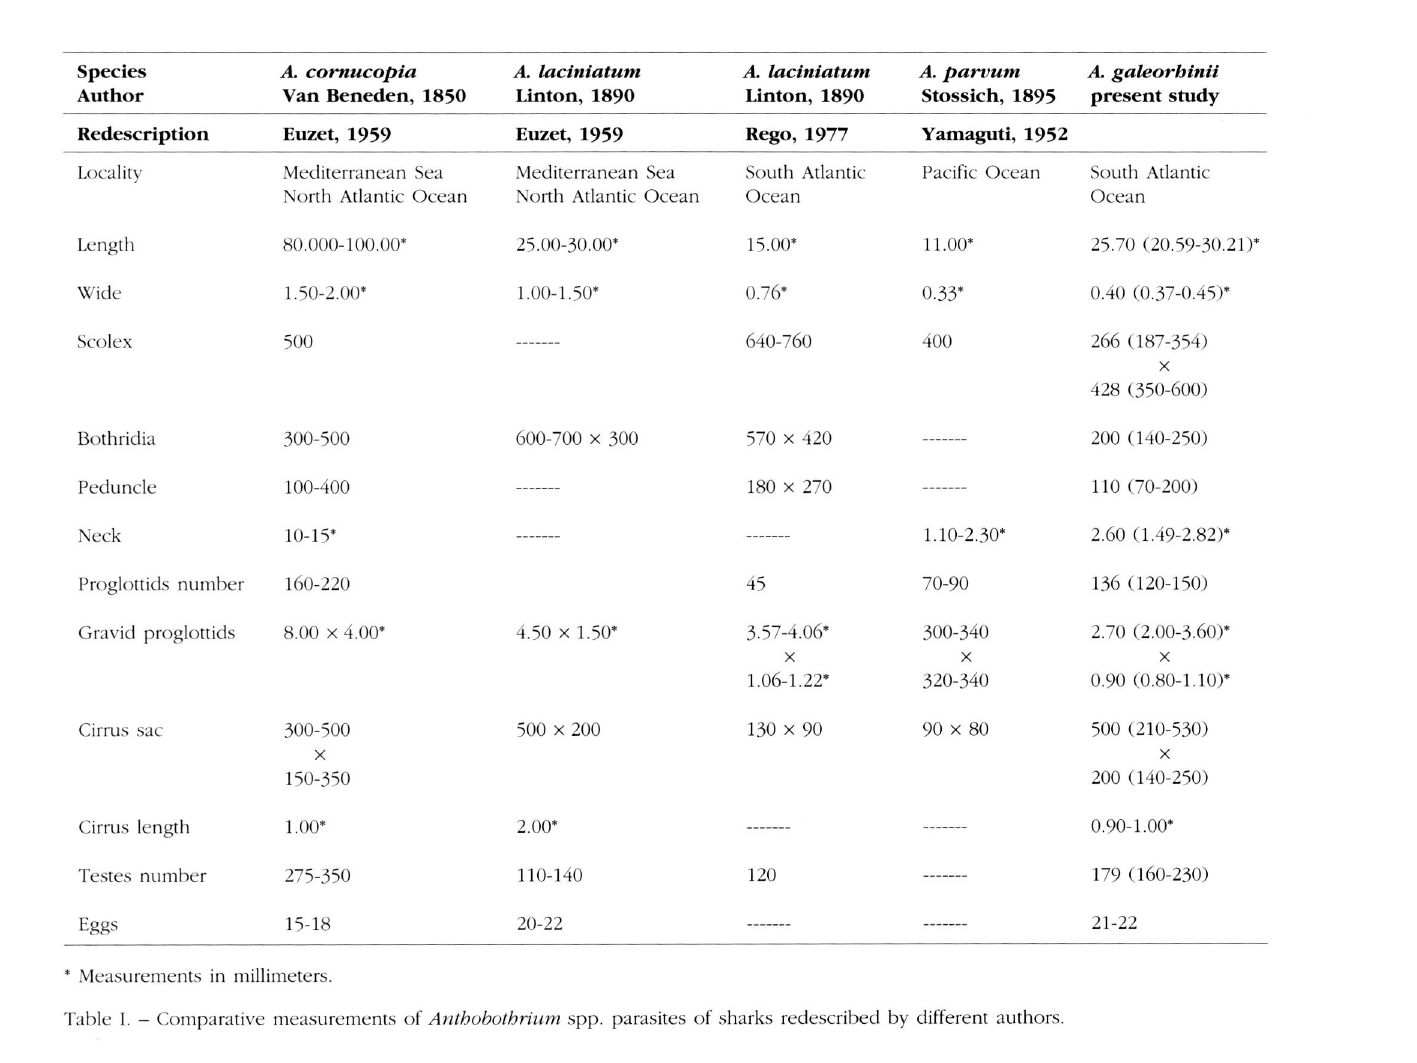
Table I. - Comparative measurements of Anthobothrium spp. parasites of sharks redescribed by different